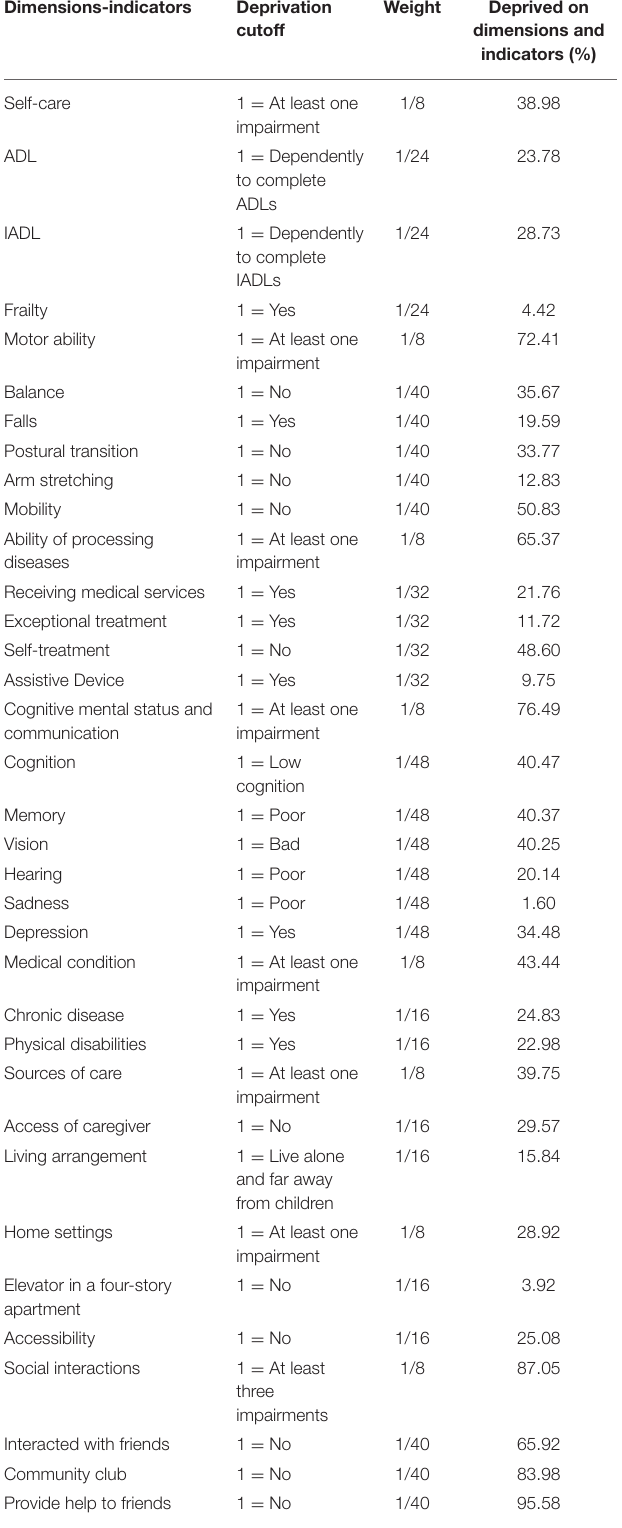
TABLE 1 | Dimensions and indicators of the multidimensional disability and its cut-off. Dimensions-indicators Deprivation